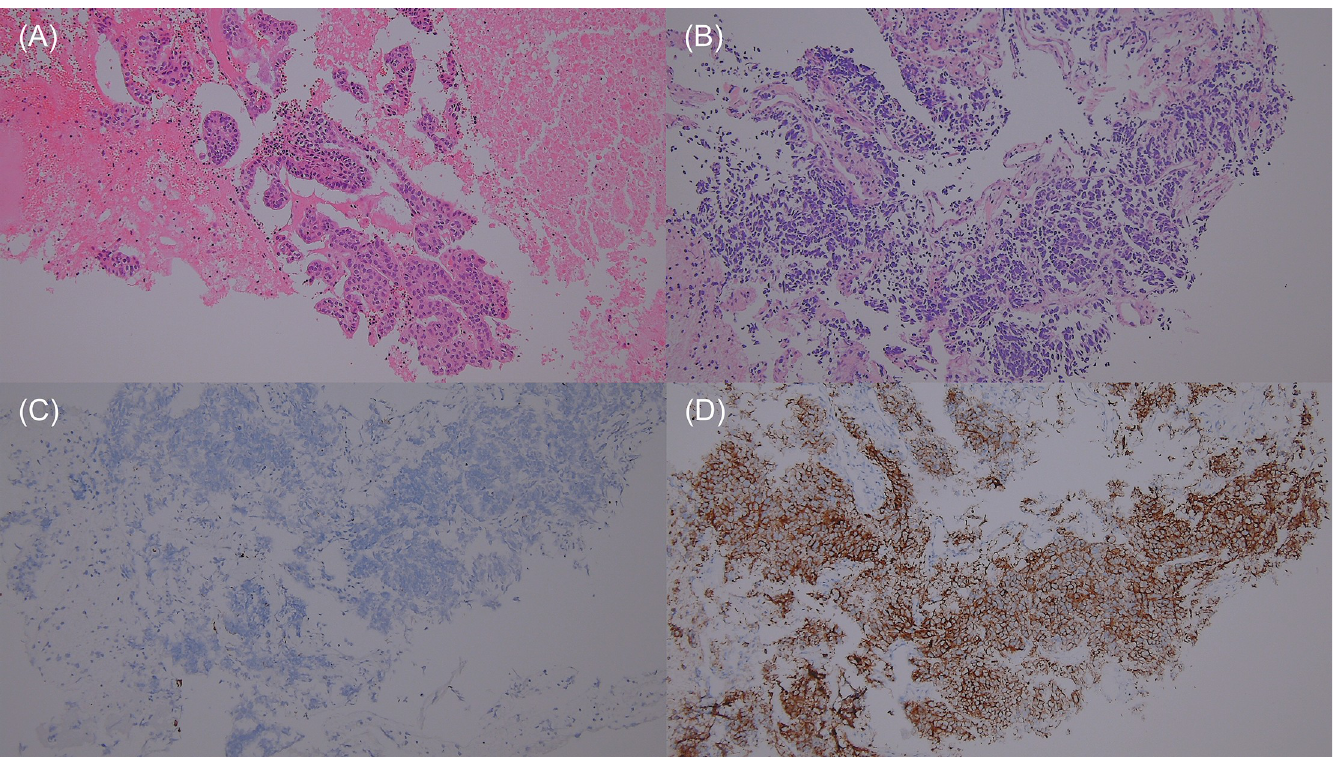
Fig 3. Transformation to small cell carcinoma from adenocarcinoma. (A) Adenocarcinoma, H&E; (B) small cell carcinoma, H&E; (C) small cell carcinoma, CK; (D) small cell carcinoma, CD56. Abbreviations: CD56, cluster of differentiation 56; CK, cytokeratin; H&E, hematoxylin and eosin.